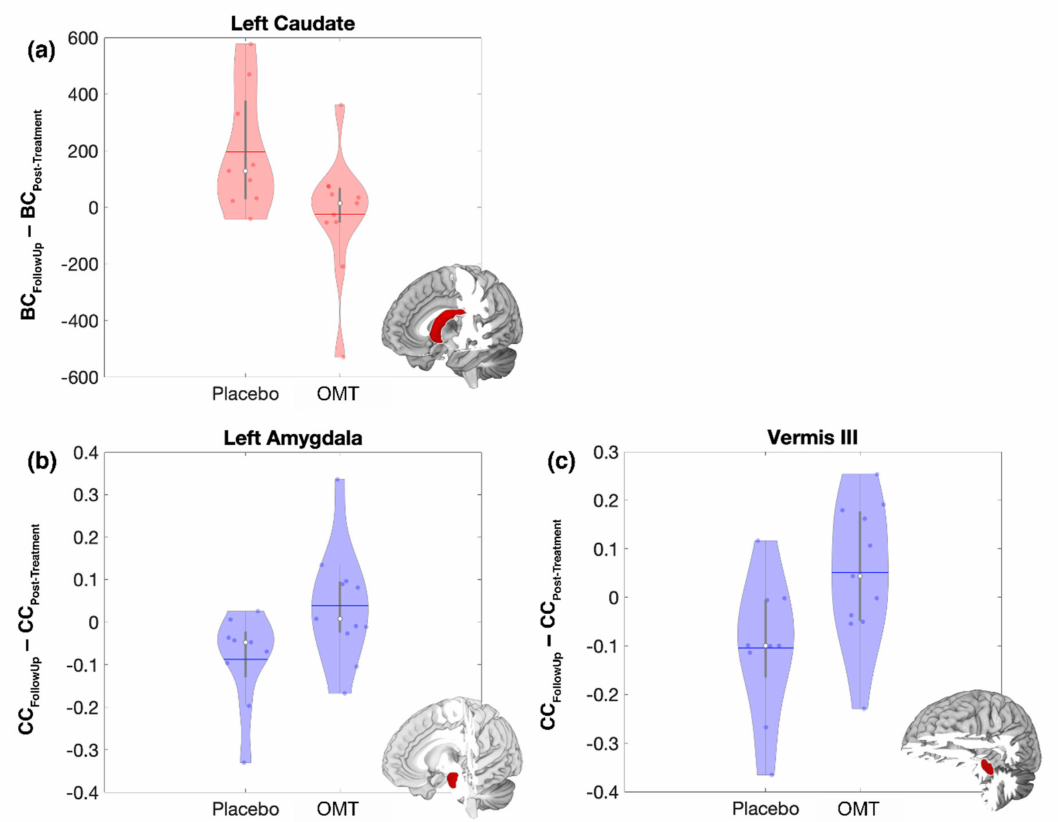
Figure 4. Post-treatment to Follow-Up changes of brain functional topological measures in the Left Caudate ( a ), Left Amygdala ( b ) and in the Vermis III ( c ). Violin plots of the statistically significant di ff erence between the follow-up and post-treatment values of Betweenness Centrality (BC, red) and Clustering Coe ffi cient (CC, blue) for the Osteopathic Manipulative Treatment (OMT) and Placebo (P). The solid horizontal lines represent the mean of the distribution, while the white dots represent the median. For each plot the structural representation of the associated region is reported as the red portion of the whole brain (left Caudate, Left Amygdala and Vermis III